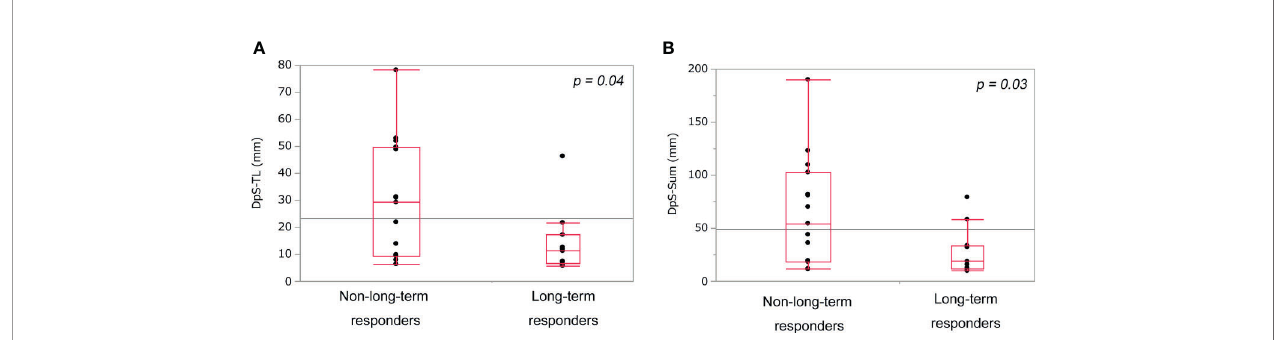
FIGURE 1 | Comparison of post-treatment burden between non-long-term responders and long-term responders. DpS-TL (A) and DpS-Sum (B) among non-long- term responders and long-term responders. DpS-TL and DpS-Sum were signi fi cantly smaller in long-term responders than non-long-term responders. DpS-TL: the maximum shrinkage values of MaxTL (the maximum tumor diameter of target lesion) during the clinical course, DpS-Sum: the maximum shrinkage values of SumTLs (the sum of diameters of target lesions) during the